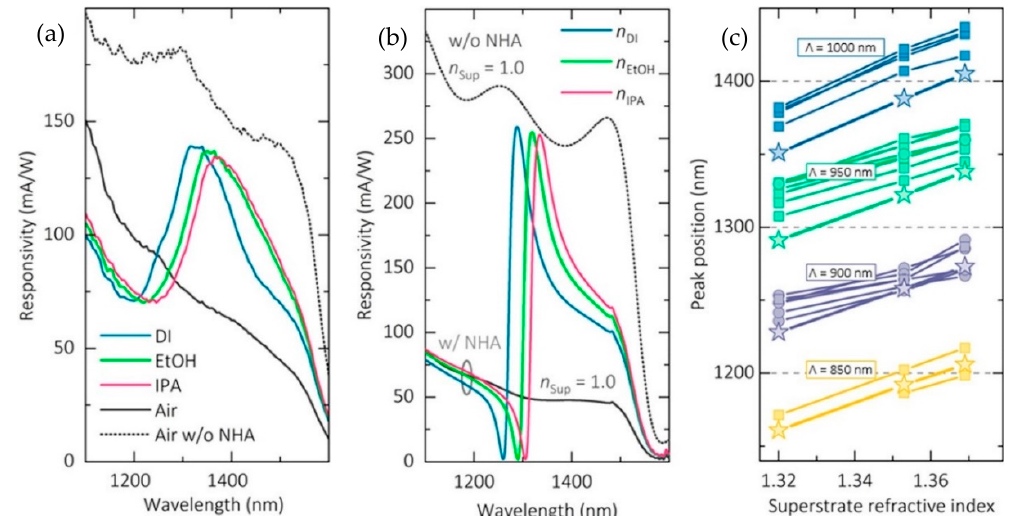
Figure 9. Experimental results detailed in Augel et al. [73]. ( a ) Experimental responsivity spectrum of the device for different refractive indices of the surrounding medium. The physical parameters of the nanohole array were as follows; pitch 950 nm, hole diameter 480 nm, germanium layer thickness 700 nm. ( b ) Simulation results for the responsivity of the device having parameters similar to (a). The peak position of the responsivity red shifts as the refractive index increases. ( c ) Responsivity peak positions versus refractive indices for different combinations of the device physical parameters.